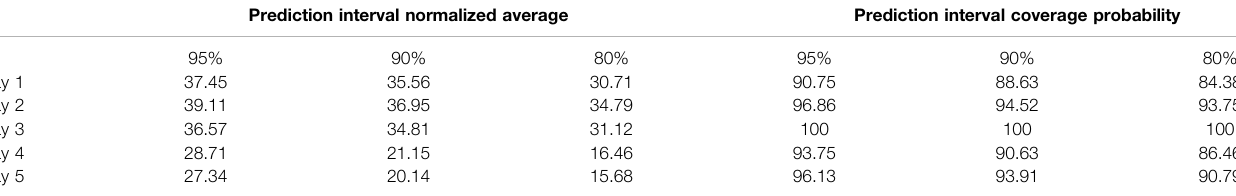
TABLE 6 | Indicator results based on normal